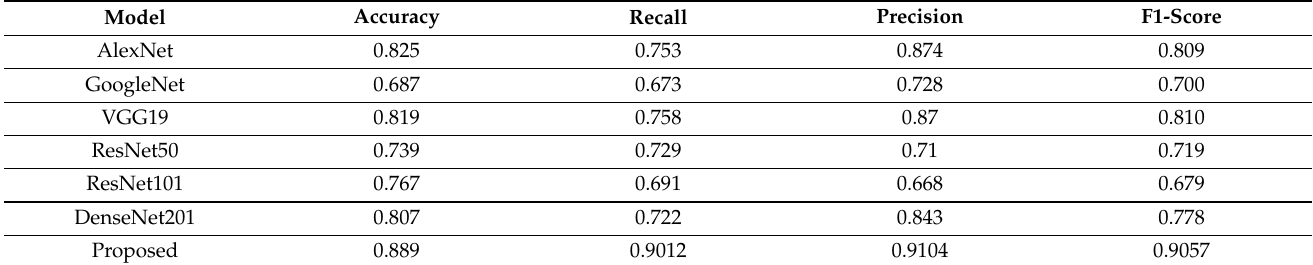
Table 4. Comparison with standard models for all categories on test dataset